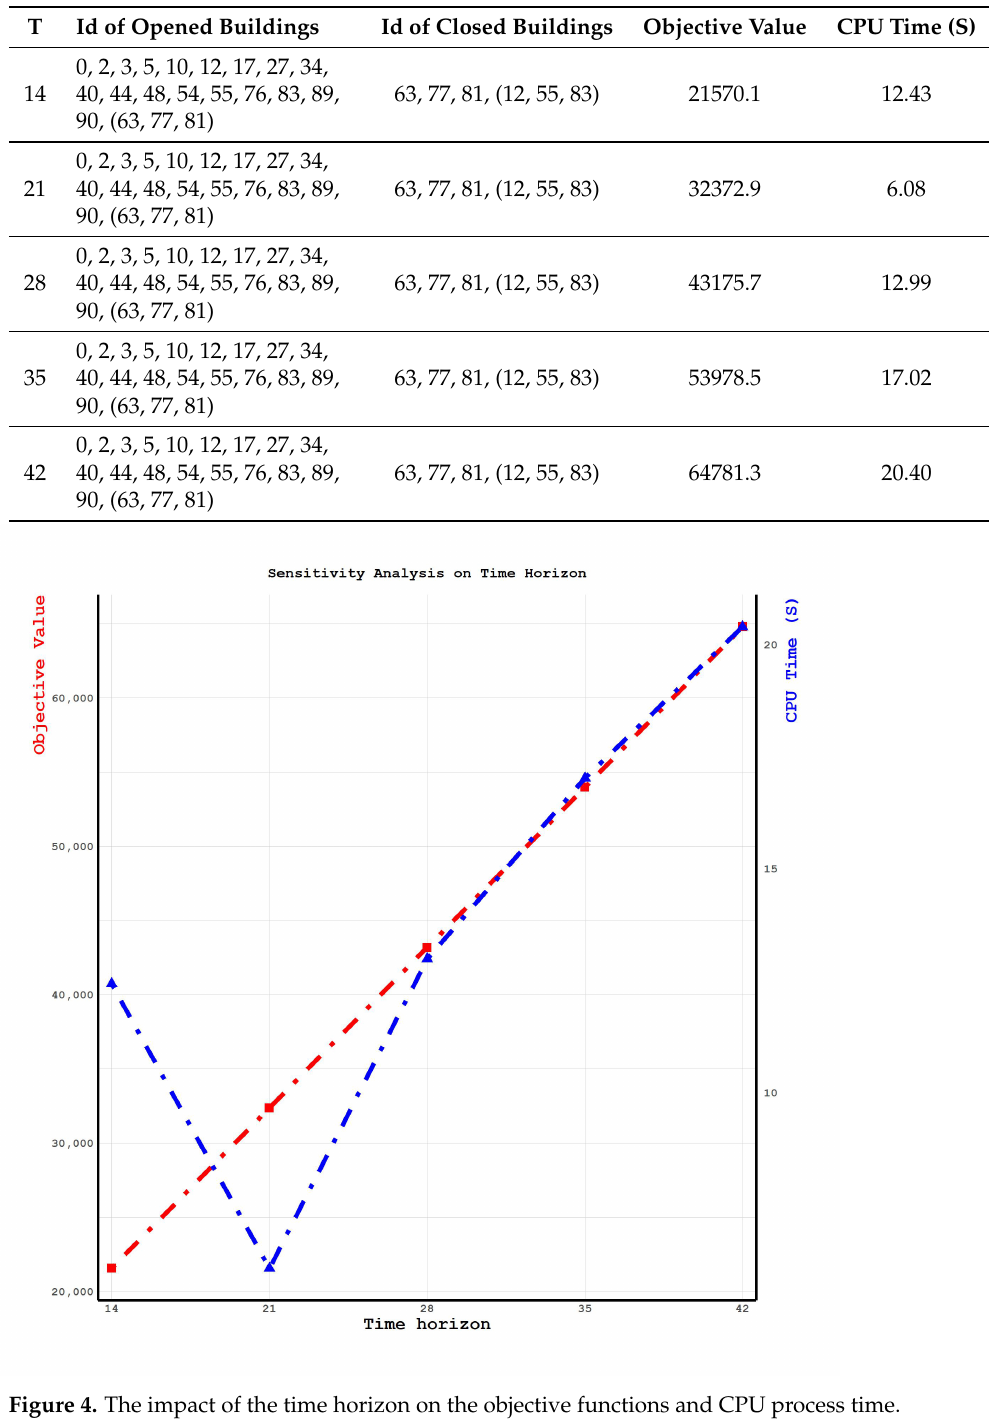
Table 12. Sensitivity Analysis on Time Horizon.